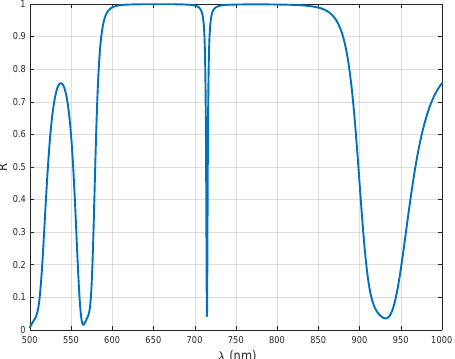
Figure 2. Reflectance spectra of our design at normal incidence with defect layer as air.